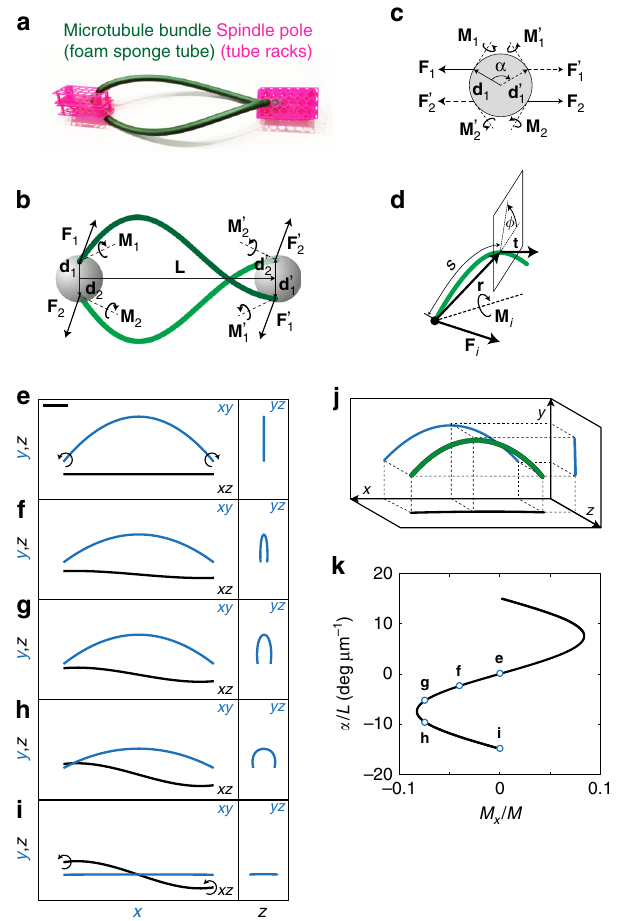
Fig. 3 Theory for shapes of microtubule bundles. a Macroscopic model of the spindle constructed as an illustration of our physical model. b Scheme of the model. Microtubule bundles (green) extend between spindle poles (spheres) at the distance L . Straight arrows denote forces F 1,2 , F ′ and 1 ; 2 positions at the spheres d 1,2 , d ′ ; curved arrows denote torques M 1 ; 2 ; M ′ . 1 ; 2 1 ; 2 c View at the spindle pole along the spindle axis. The angle between the vectors d 1 and d ′ is α ; other symbols as in b . d Scheme of a bundle. Arrows 1 depict contour length s , radial vector r , normalized tangent vector t , and torsion angle ϕ ; other symbols as in b . e – i Predicted shapes of the bundles. Three projections: left, xy (blue), xz (black); right, yz (blue), see scheme in j . Parameters are: M 1 = (0,0,180), ( − 5, − 30,111), ( − 10, − 70,115), ( − 10, − 128,80), (0, − 150,0) pN μ m for e – i , respectively. j Scheme of the projections from e to i . k Twist of a microtubule bundle, α , divided by spindle length, L , as a function of the twisting moment, M x = M ix , q ffiffiffiffiffiffiffiffiffiffiffiffiffiffiffiffiffiffiffiffi M 2 þ M 2 (the same curve for normalized to the bending moment, M ¼ iy iz i = 1,2). Points denoted by letters e – i correspond to the shapes shown in respective panels. The other parameters are L = 12 μ m, d = 1 μ m, and κ = 900 pN μ m 2 . Scale bars, 2 μ